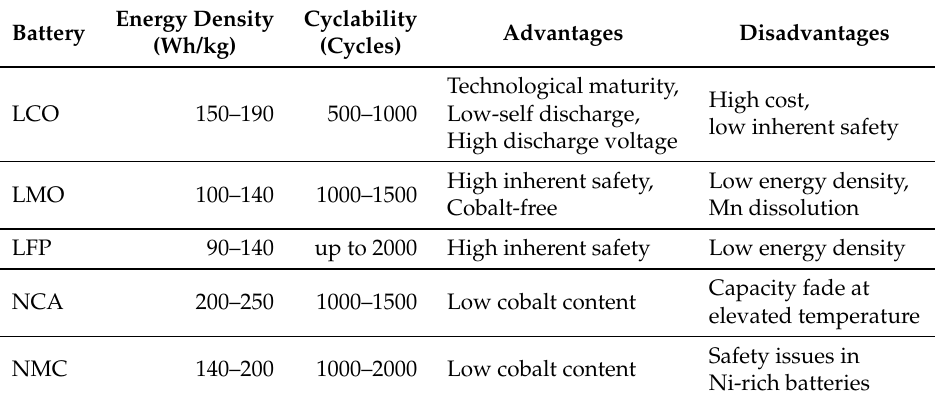
Table 1. Main characteristics of different Li-ion battery